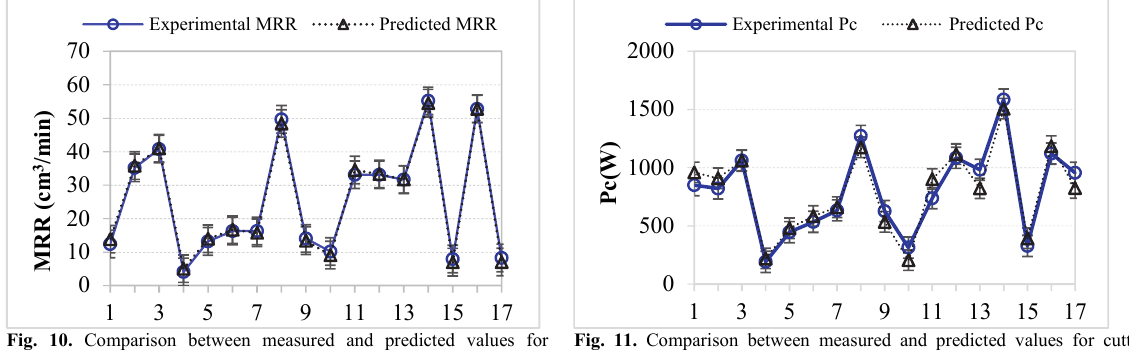
Fig. 11. Comparison between measured and predicted values for cutting power